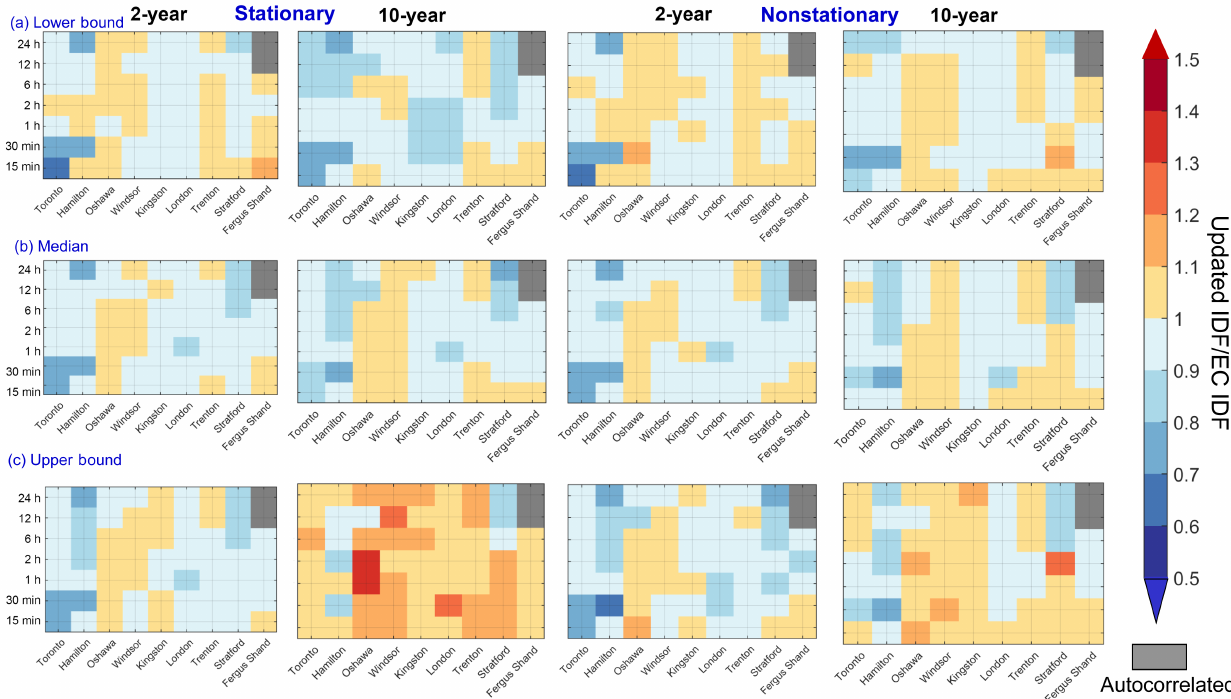
Figure 6. Central tendency (median, b ) and the bounds (95% credible interval, a and c ) of the updated nonstationary vs. EC-generated T = 2- and 10-year event estimates for DSI at selected return periods with durations between 15min and 24h. The DSI and associated 95% confidence limits of EC-generated IDF are obtained from the national archive of Engineering Climate Datasets (http://climate.weather.gc.ca/). The shades in blue and red denote decrease and increase in DSI. The strength of the shading represents the magnitude of the ratio between updated and EC-generated